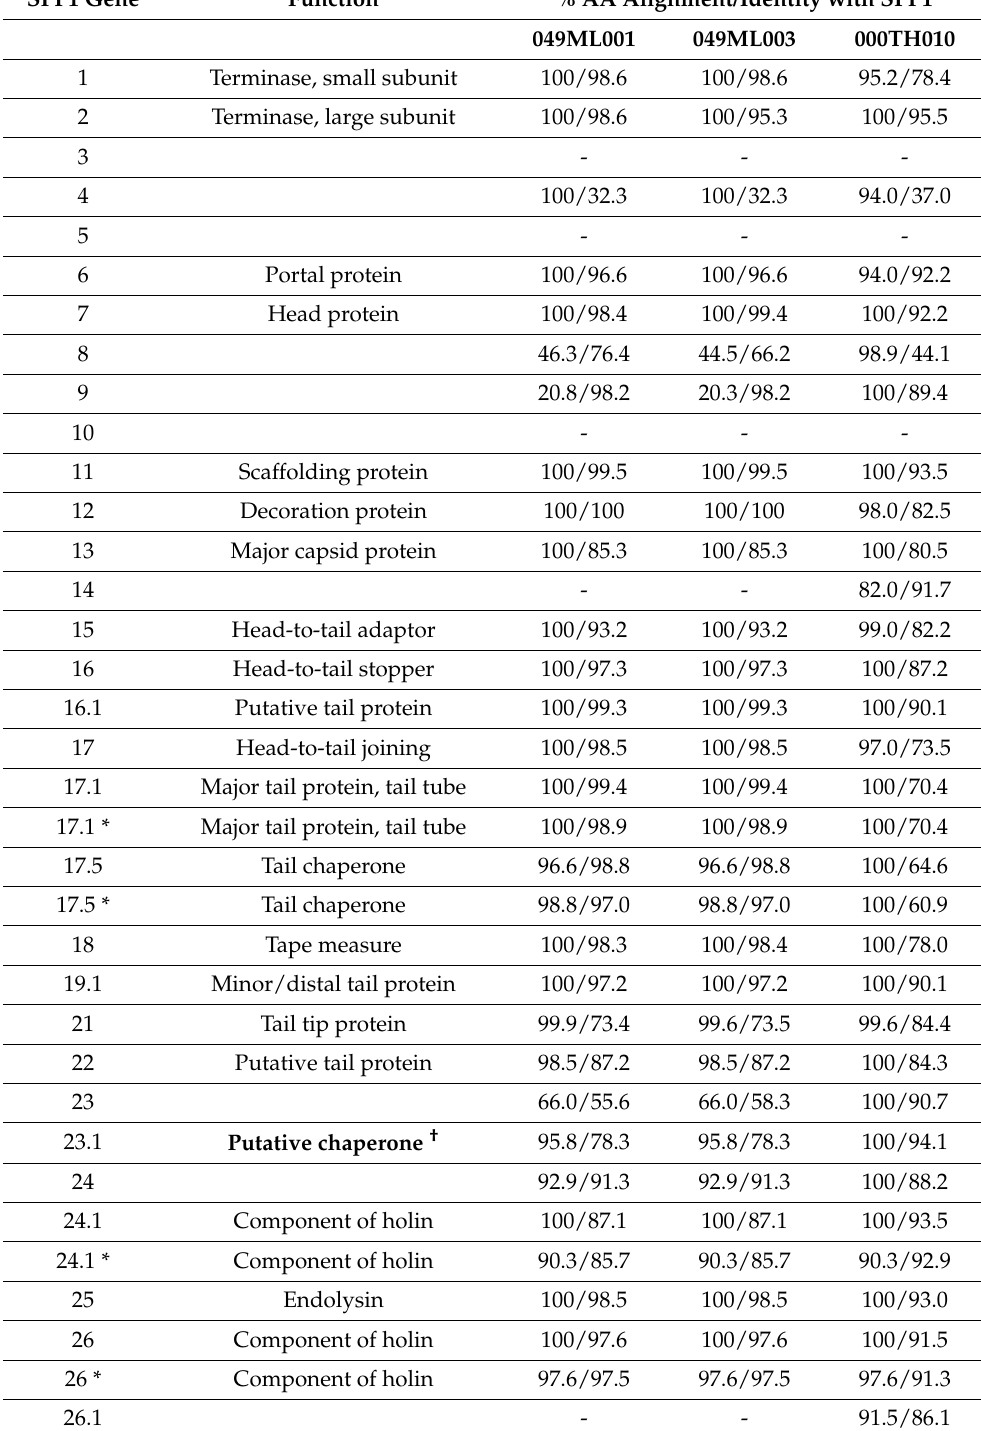
Table 2. Comparison of our phages to the revisited annotation of phage SPP1 from [25]. SPP1 gene numbers/names (e.g., 17, 17.1, and 17.1 *) follow naming convention established for SPP1 [25]. We added one putative gene not called previously (gene 46.2) based on homologs present in our other phages. In addition to function listed in [25], we called function for three additional genes (in bold) based on HHPred matches or a published study (†; [26]). If putative homologs were found in our recently isolated phages, % amino acid (aa) alignment/identity with SPP1 are given, as determined by